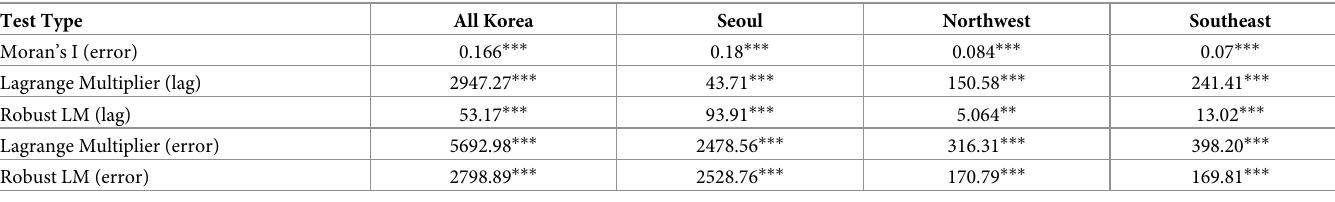
tial econometric models because it represents the spatial relationship between observations. check model robustness with different spatial weight matrices based on spatial patterns and Table 2. Moran’s I statistics for residuals, LM, and robust LM test